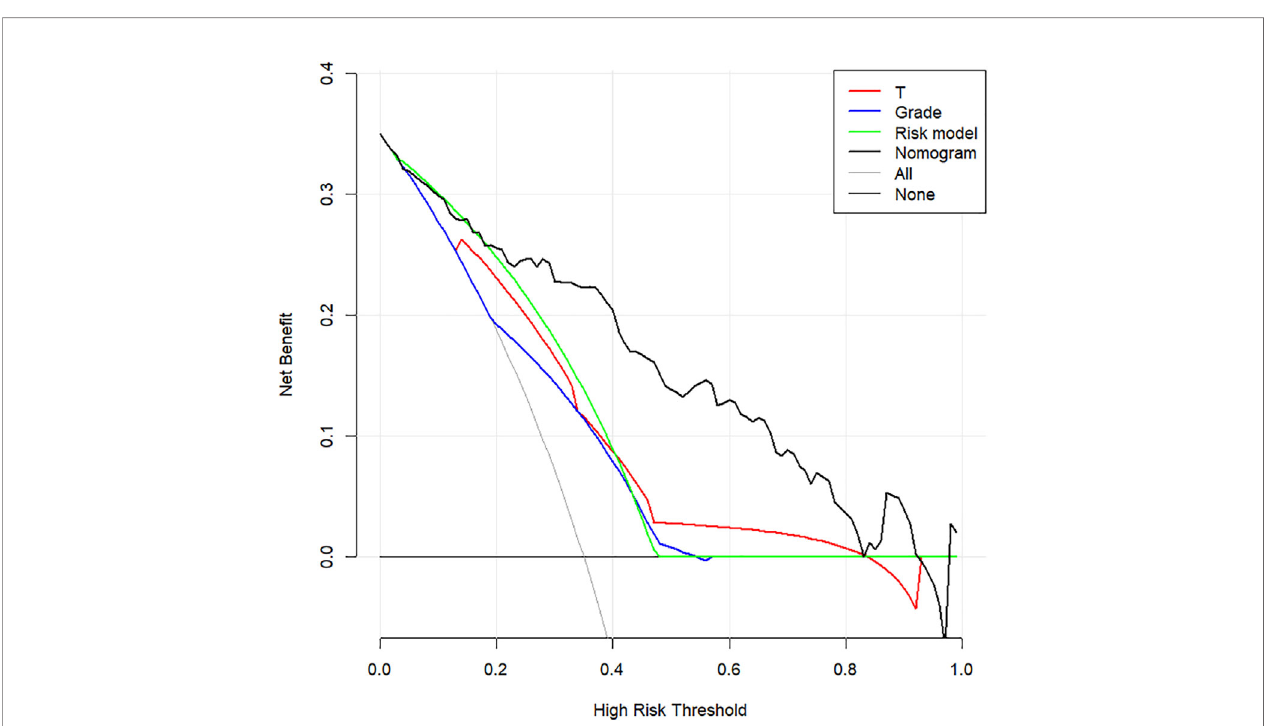
FIGURE 5 | Decisioncurve analysistoassesstheclinicalusefulness ofthenomogram,Tstage, grade,RiskmodelandENE. Tstage,tumor stage;ENE, extranodalextension.